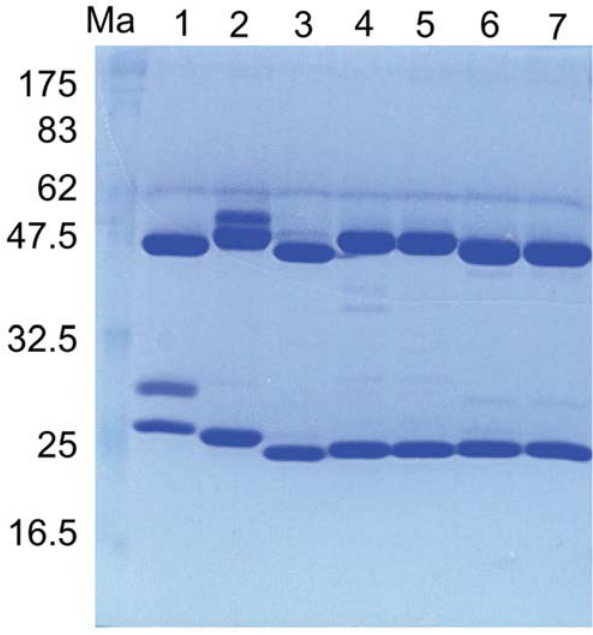
Figure 1. Coomassie blue staining of purified MoMabs (5 m g/ well) demonstrating appropriate size of light chain and heavy chain. Ma–molecular weight marker in kD; lane1, E559 (batch # 603-02); lane 2, 62-7-13 (batch # 604-26); lane 3, 1112-1 (batch # 604-26); lane 4,